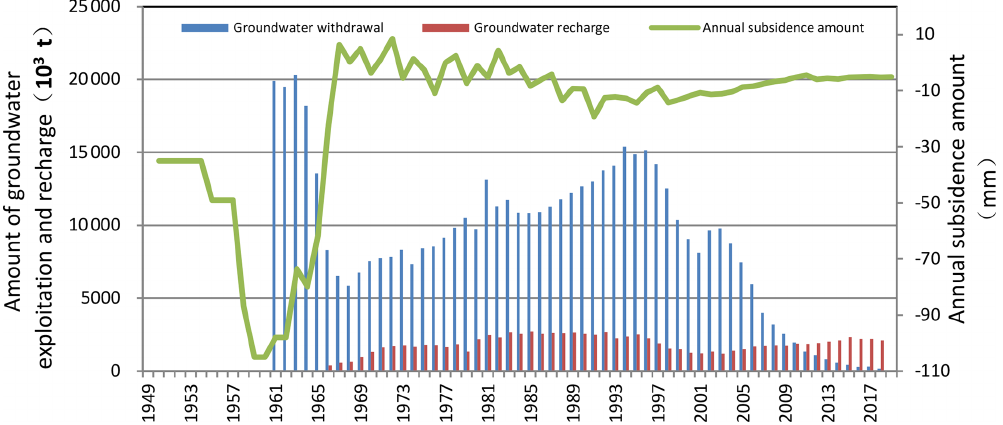
Figure 2. Historical graph of annual groundwater intake and land subsidence in